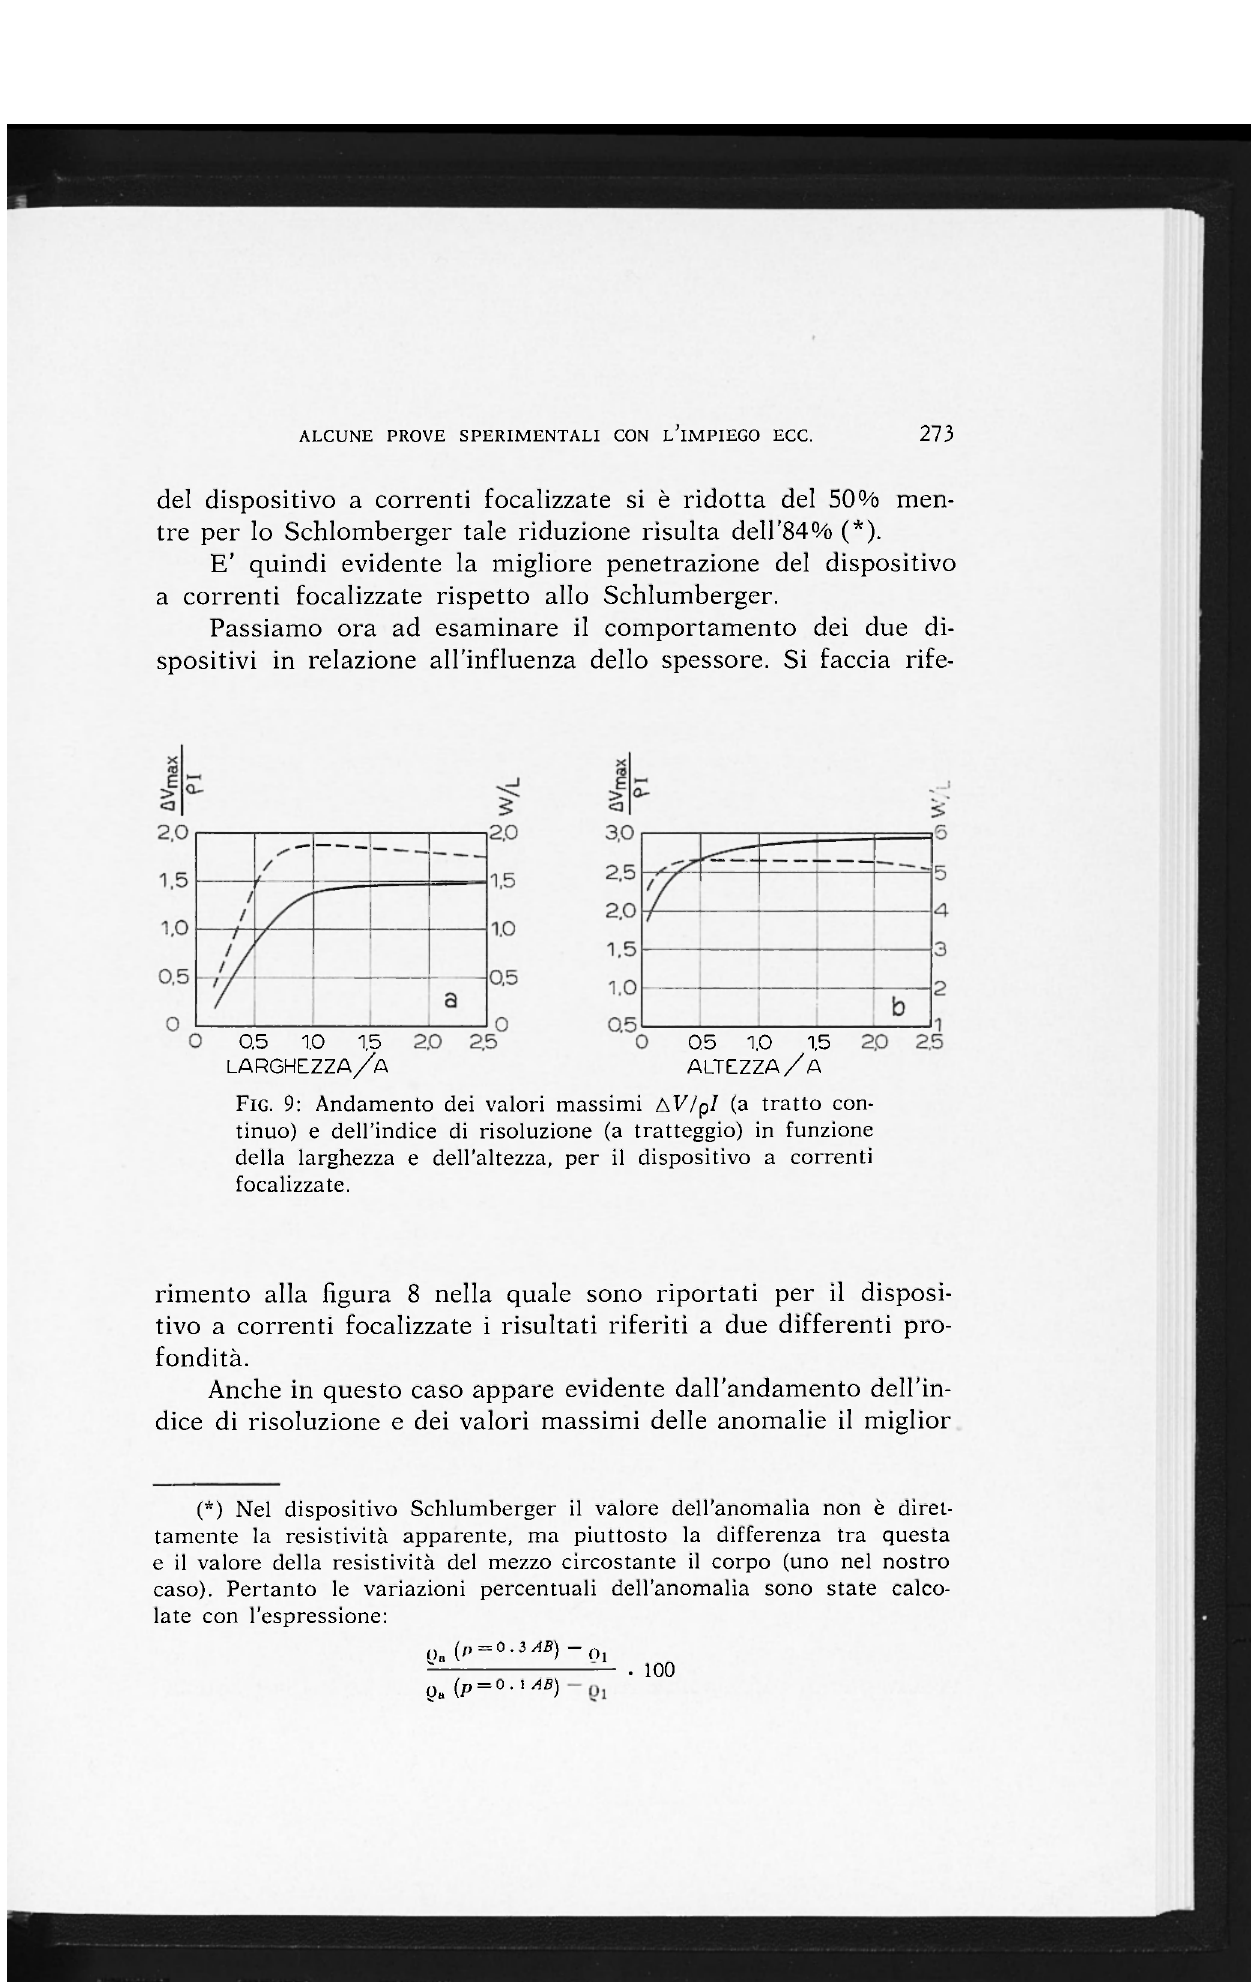
FIG. 9: Andamento dei valori massimi AWp/ (a tratto